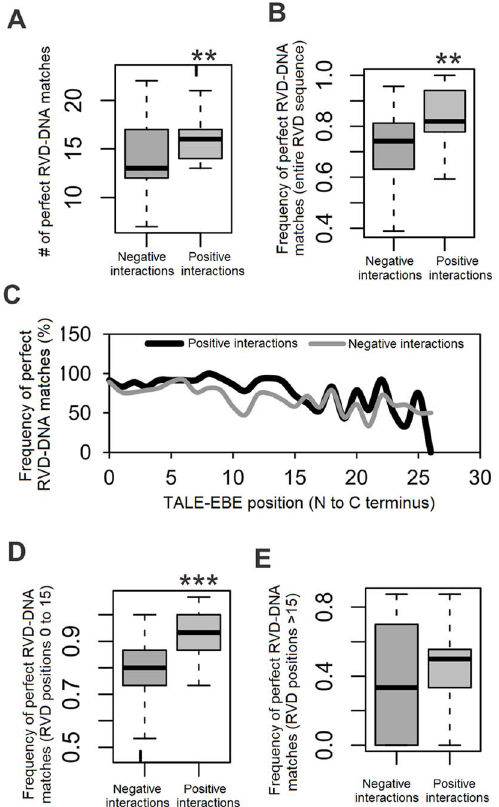
Figure 2. Distribution of perfect matches (PM) in the TALE-EBE validation set. ( A ) Box plot of the distribution of the number of perfect RVD-nucleotide matches computed for individual negative and positive control TALE-EBE pairs. ( B ) Distribution of perfect match frequency of individual control TALE-EBE pairs. The frequency corresponds to the ratio of the number of perfect RVD-nucleotide matches to TALE length expressed in number of RVD. ( C ) Frequency of perfect matches across TALE-DNA positions. The frequency corresponds to the ratio of the number of perfect RVD-nucleotide at the considered position to the total number of RVD-nucleotide pairs at this position in TALE-EBE pairs of the positive or negative control set. ( D ) Frequency of perfect RVD-nucleotide match between positions 1 and 15 (=number of PM/15). ( E ) Frequency of perfect match for TALE-DNA positions beyond 15 ( = number of PM/(length-15)). The p-value of the corresponding two-tailed Wilcoxon test in this comparison is 0.371. ** significant differences, one-tailed Wilcoxon test p-value , 0.001; *** significant differences one-tailed Wilcoxon p-value , 1e-7.